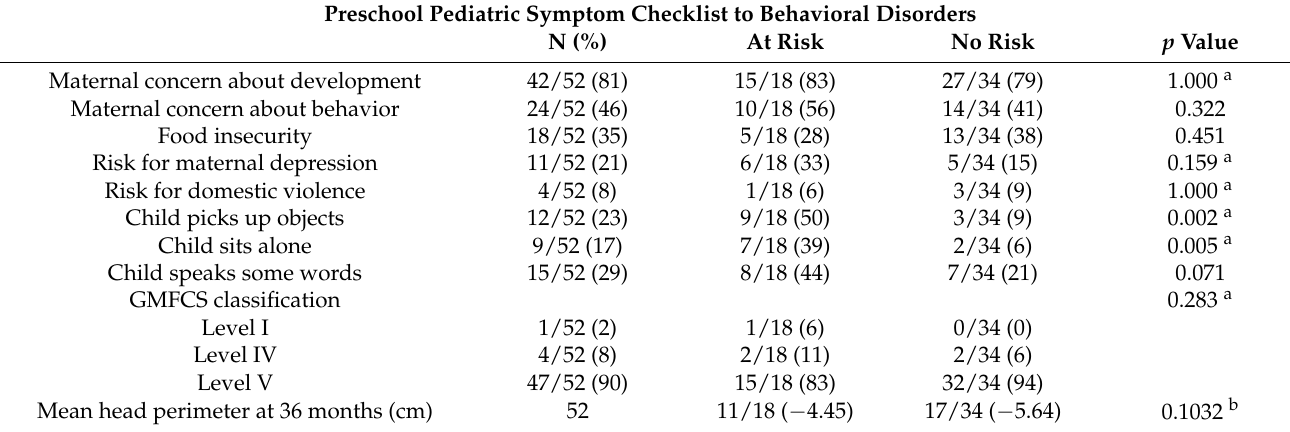
Table 3. Family and child characteristics according to risk of behavior disorder.